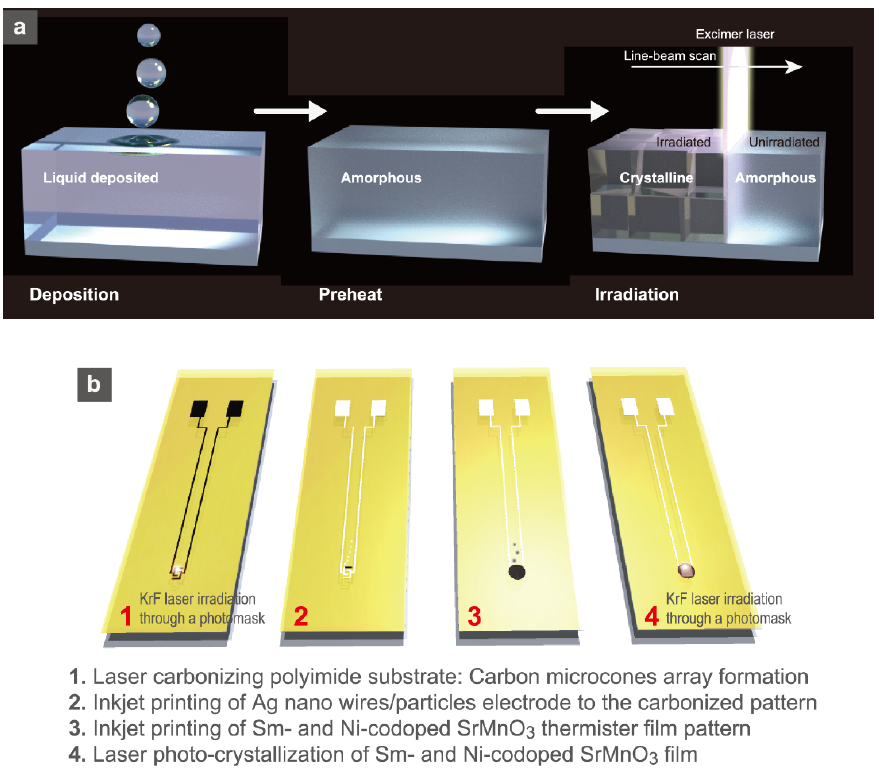
Figure 14. Schematics of ( a ) procedure of photocrystallization using an excimer laser for precursor films prepared by the CSD method. ( b ) Fabrication steps for Ag/carbon micro-cones composite electrodes and Sm- and Ni-codoped SrMnO 3 thermistor sensors. Reprinted with permission from Ref. [53]. Copyright 2020 American Chemical Society.